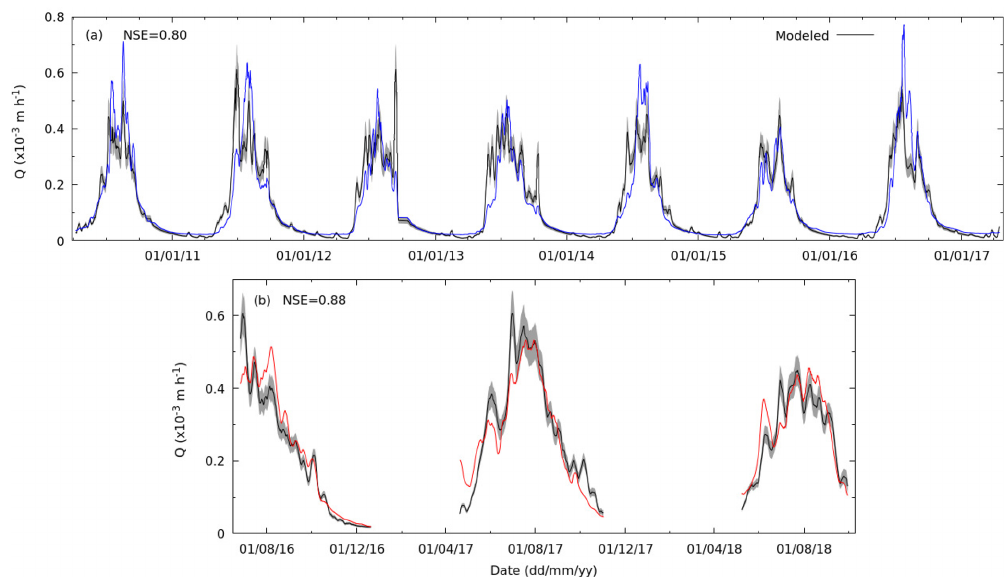
Figure 5. Modelled weekly runoff (black lines, with grey bands denoting 2 σ uncertainty) compared with the corresponding observations for the (a) upper Dudhkoshi (solid blue line), and (b) Chandra (solid red line)